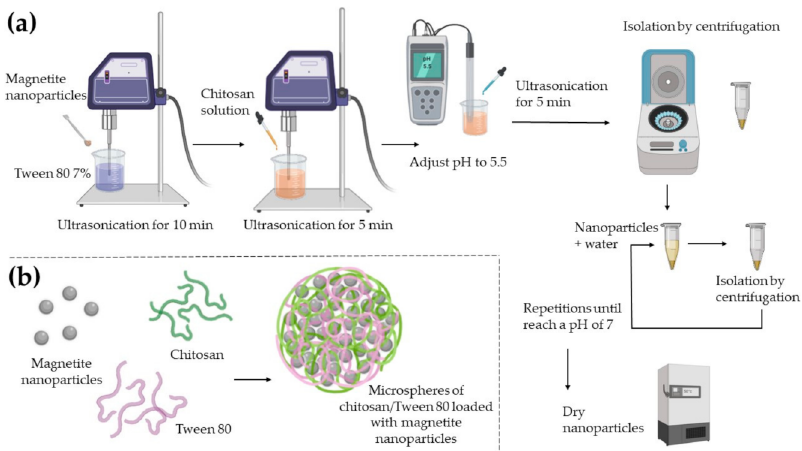
Figure 1. A scheme cartoon of the preparation of the microspheres. ( a ) A complete diagram of the methodology; ( b ) The interaction of chitosan and Tween 80 generate microspheres, which load the magnetite nanoparticles into a polymer network. Created with